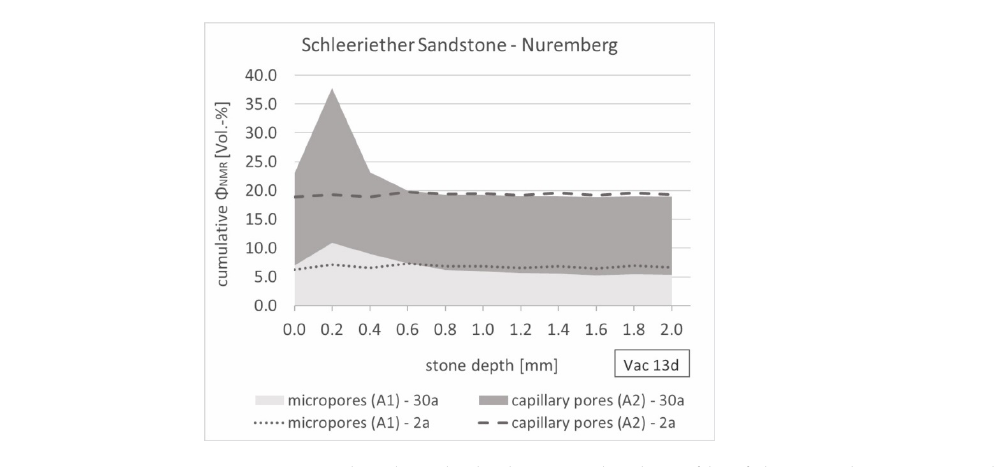
which you can find also in the appendix.